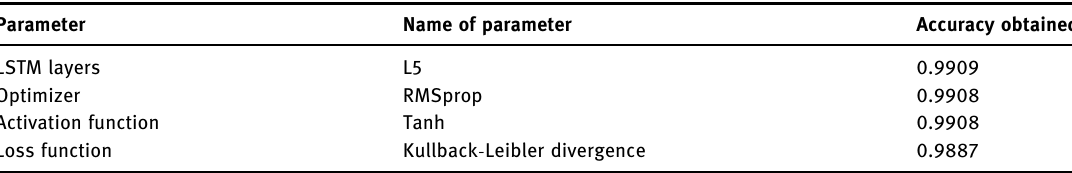
Table 1: Optimal hyperparameter tuning based on [ 16 ]